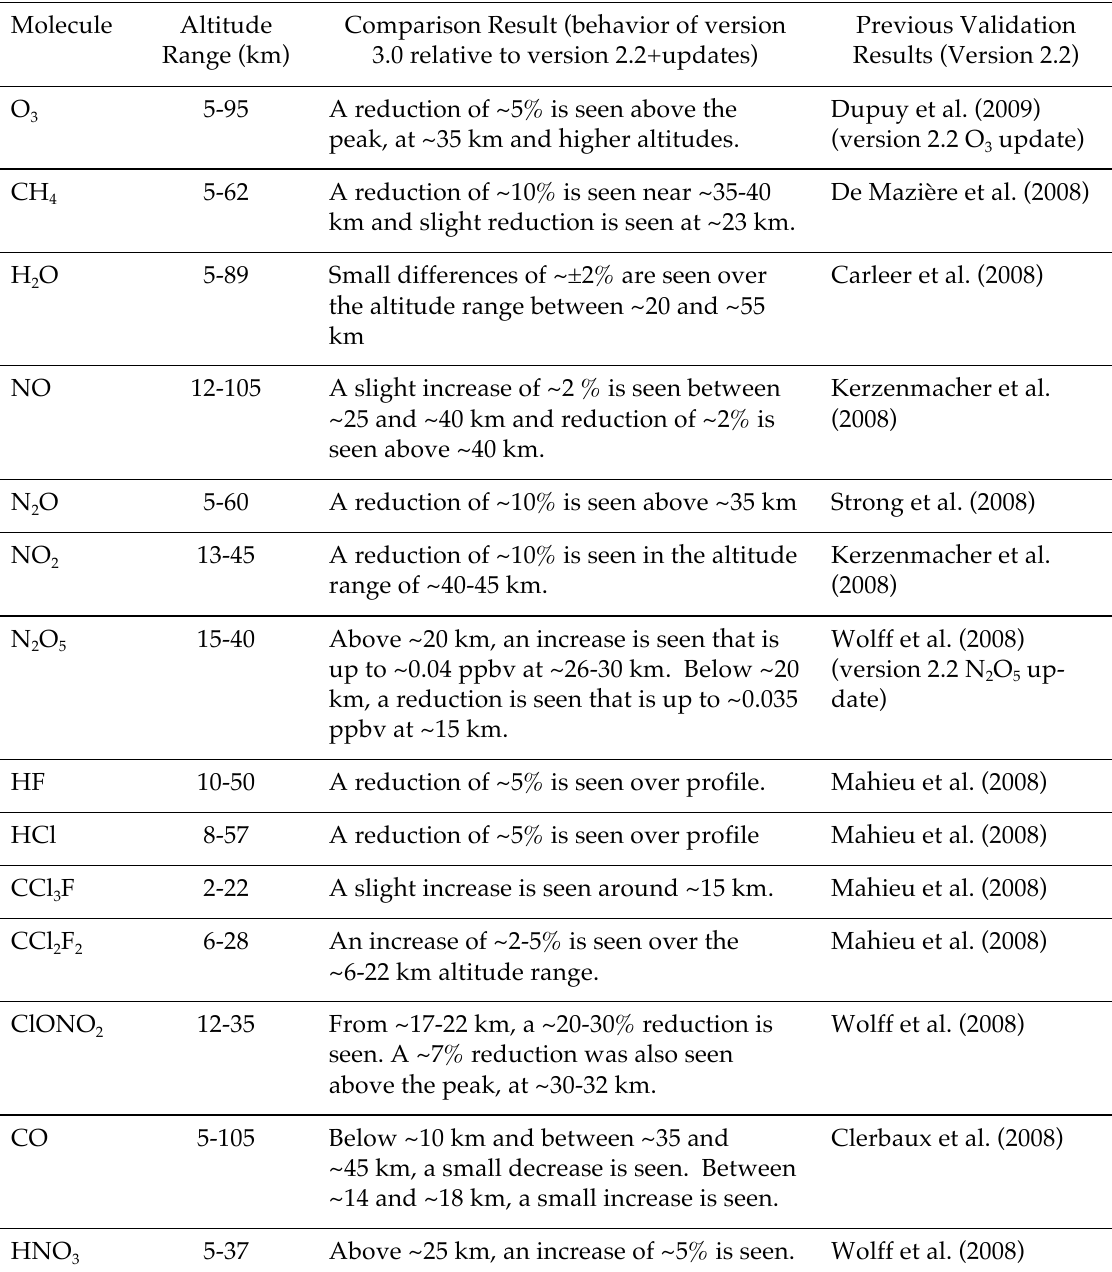
Table 2: Summary of the version 2.2+updates and version 3.0 direct version comparisons.